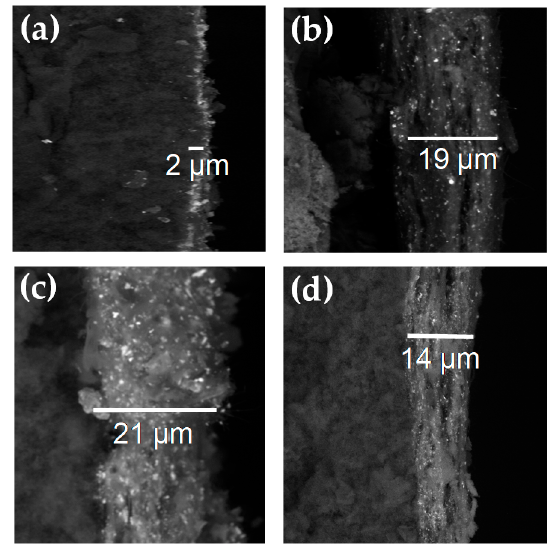
Figure 6. Scanning electron microscopy (SEM) micrographs of the membrane electrode assemblies (MEAs) catalytic layer of: ( a ) PtPd/rGO; ( b ) PtPd/MWCNT; ( c ) (PtPd/rGO) + (PtPd/MWCNT); and ( d ) PtPd(rGO:MWCNT).